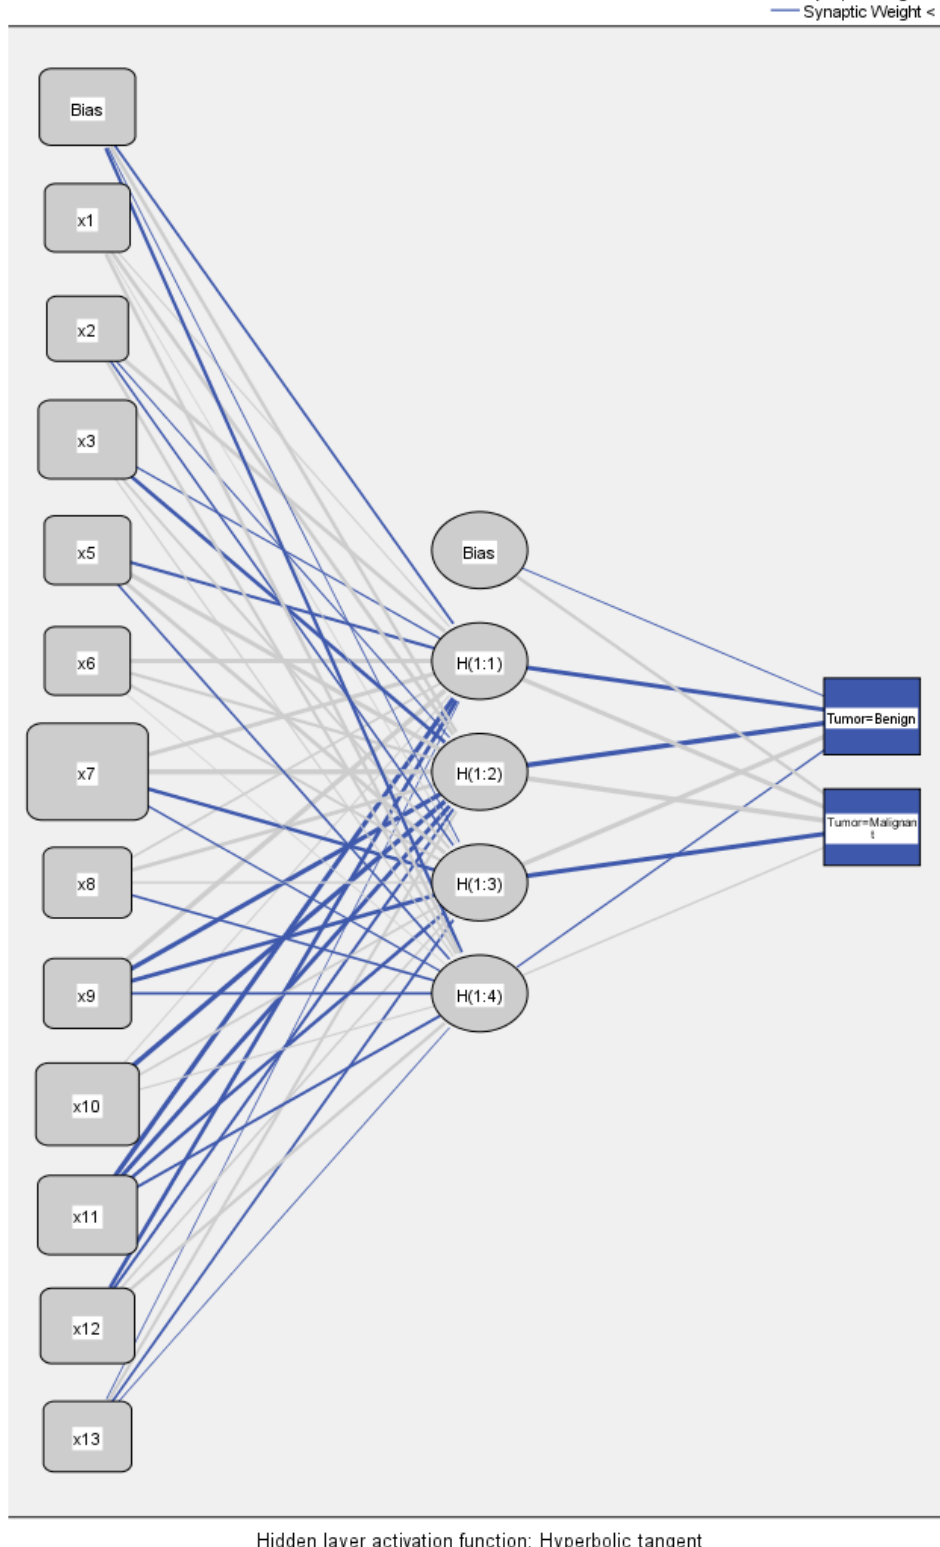
Fig. 3: Structure of the MLP